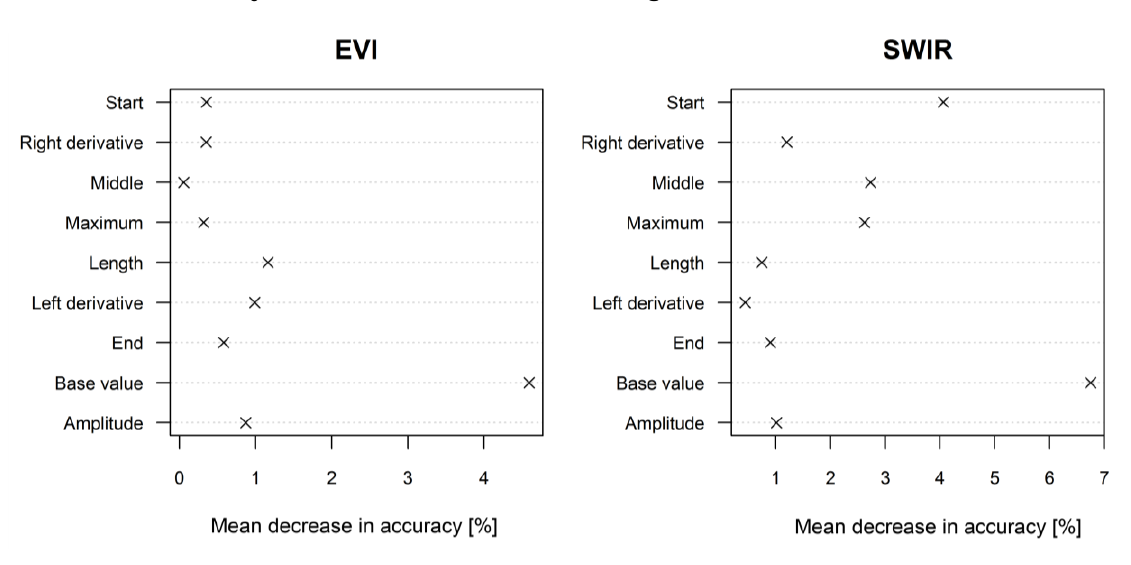
Figure 5. Variable importance measure for the overall best model based on Enhanced Vegetation Index (EVI) and short-wave infrared (SWIR) metrics, estimated by the mean decrease in accuracy if a feature is left out in building a decision tree (Section